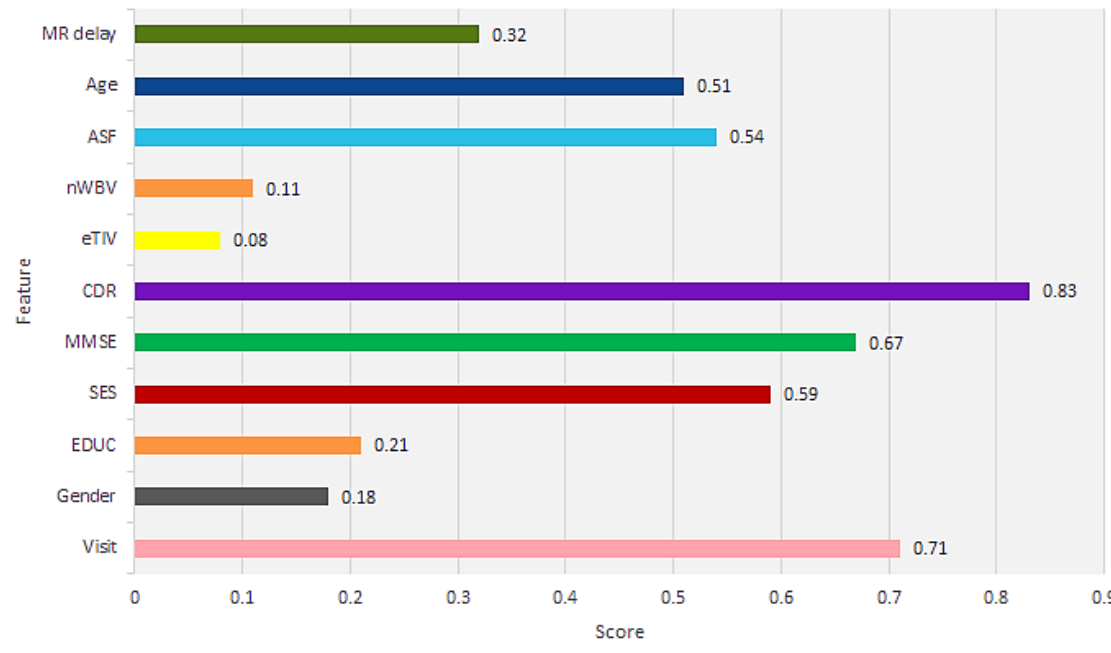
Figure 1. Individual feature scores.